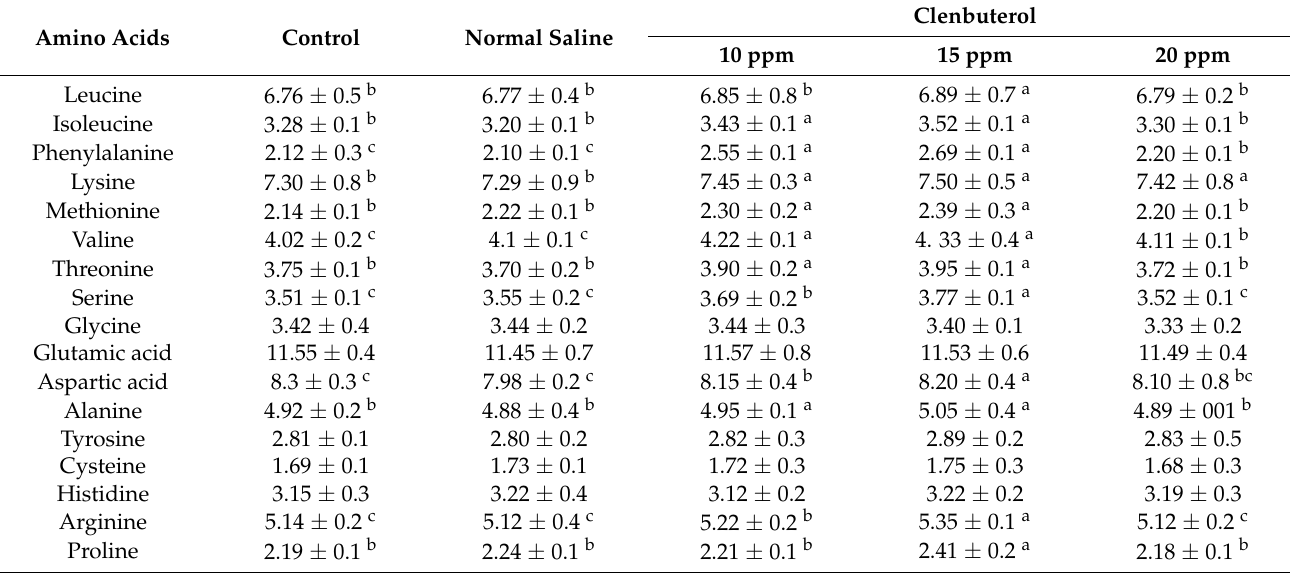
Table 7. Effect of in ovo feeding of clenbuterol on the breast muscle amino acid profile (g/100 g) of chicken breast muscle. Amino Acids